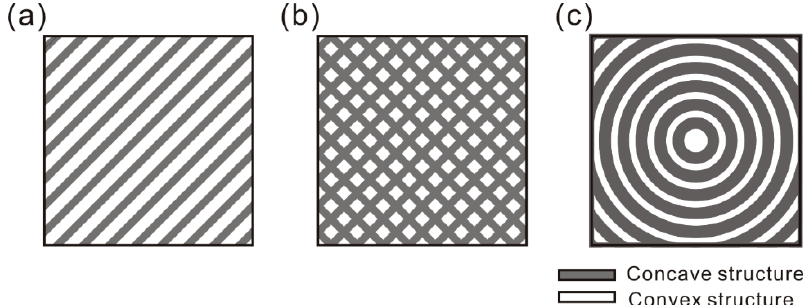
Figure 1. Schematic of the expected morphology of the micro-scale structure surfaces: ( a ) linear groove, ( b ) gridding groove, ( c ) arc groove.